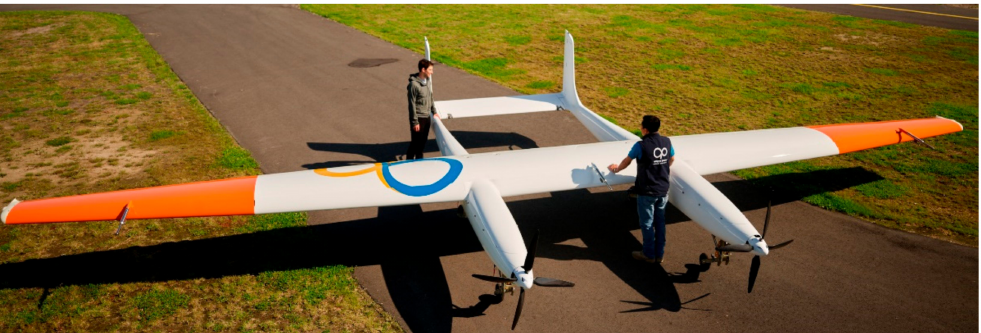
Figure 3. Ampyx Power’s AP3 during flight testing on Breda International Airport in May 2021 (photo courtesy of Ampyx Power